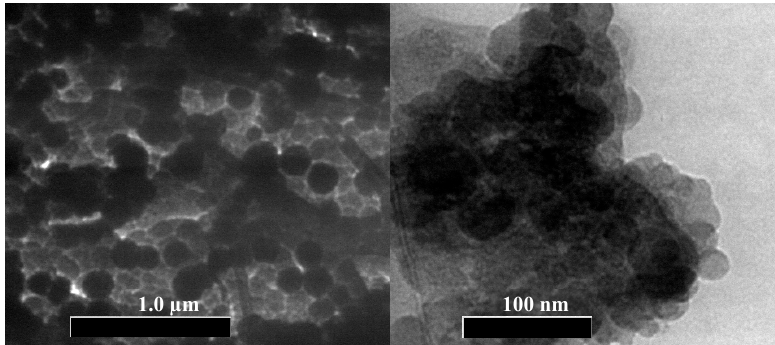
Figure 2. The TEM image of the PEG-AgNPs under different magnifications. Figure 2. TEM image of the PEG-AgNPs under different